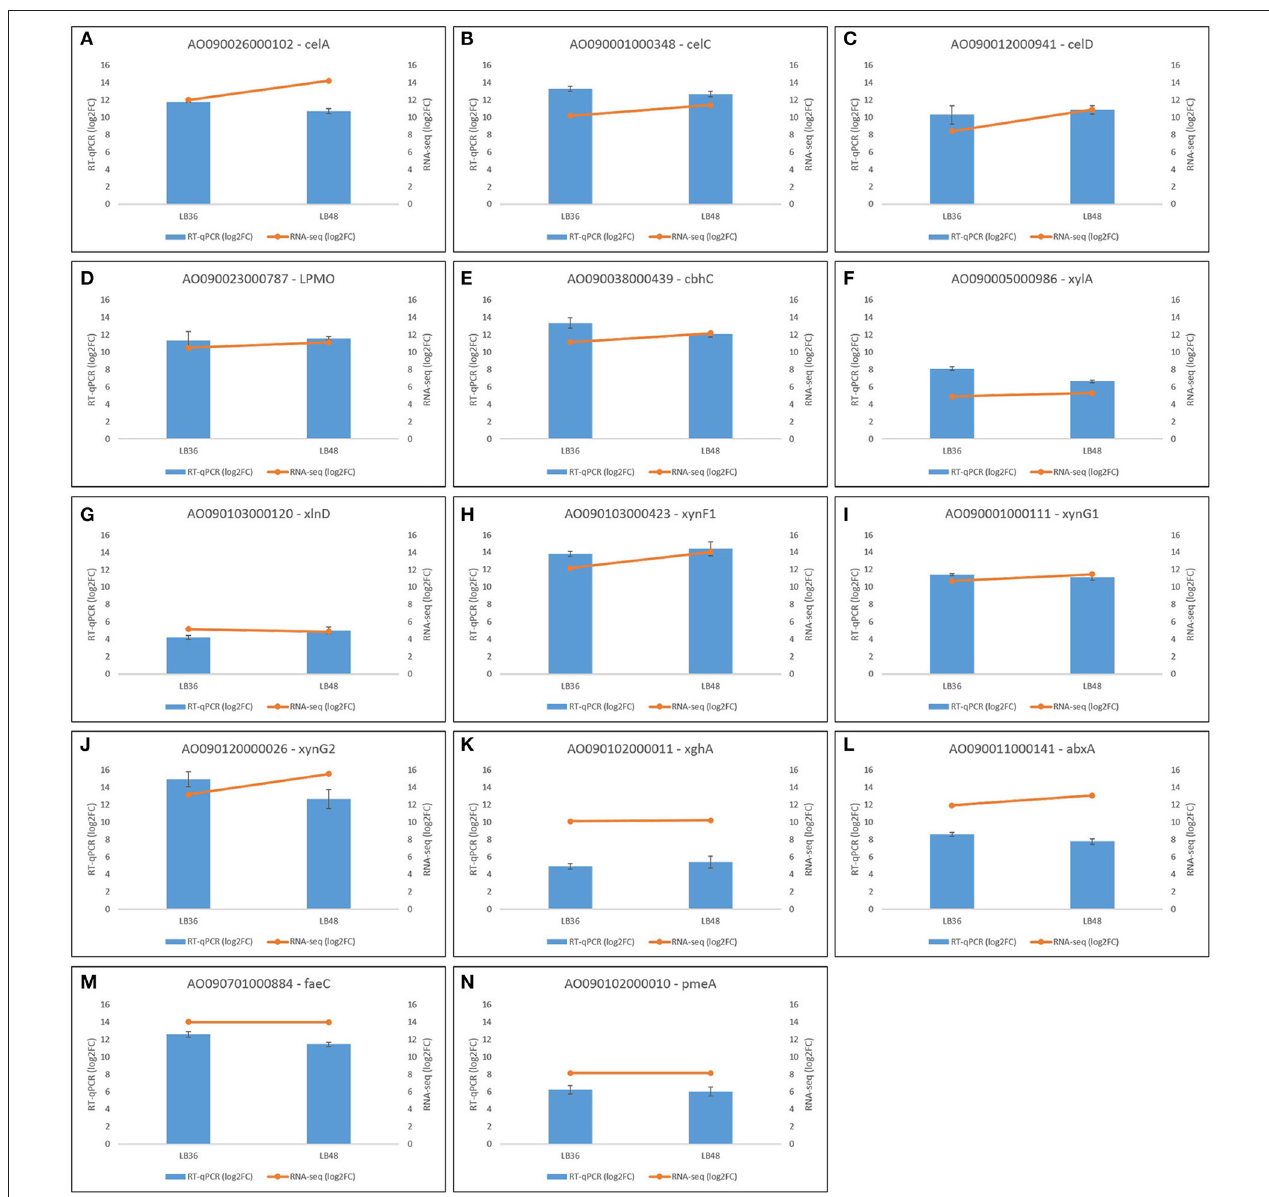
FIGURE 7 | Validation of differential gene expression profiles based on RNAseq through RT-qPCR analysis in selected genes (A–N) in Aspergillus tamarii BLU37. Black bars represent standard error values, which are based on analysis of three biological replicates per treatment and three technical amplification replicates.